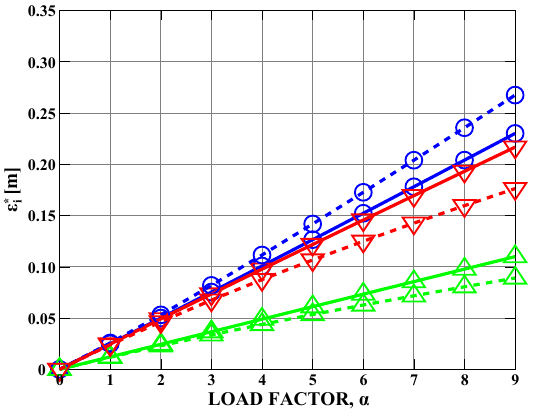
Figure 3. Components of the stretch vector: ε ∗ Typical deformation measures. Reference point K : solid line, point L : dashed line.